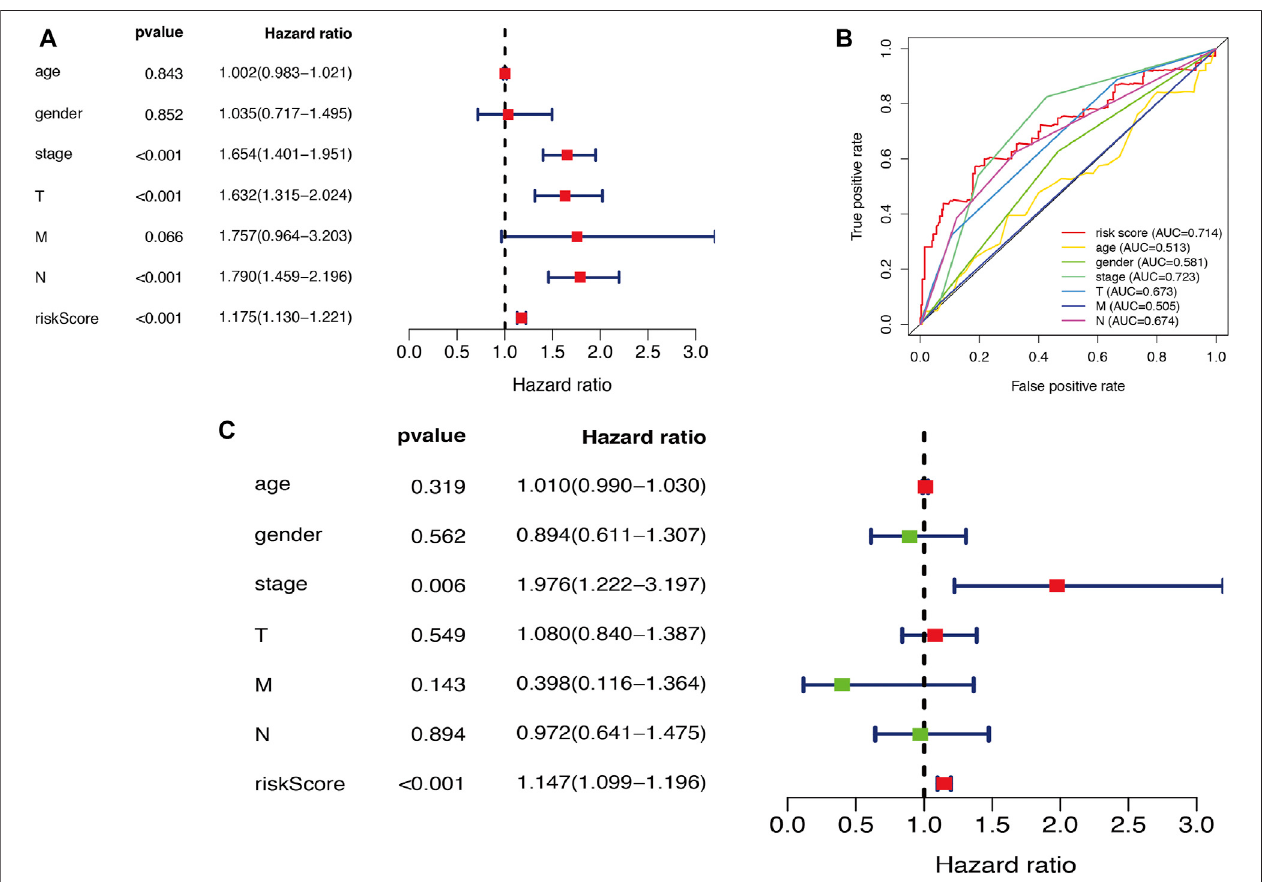
FIGURE 9 | Cox regression analysis of risk model and clinicopathological variables in LUAD. (A) Visualization of the forest map with single factor independent prognostic analysis. (B) The ROC analysis of OS for the risk model signature and the clinicopathologic variables. (C) Visualization of the forest map with multifactor independent prognostic analysis. LUAD, lung adenocarcinoma; ROC, receiver operating characteristic; OS, overall survival.